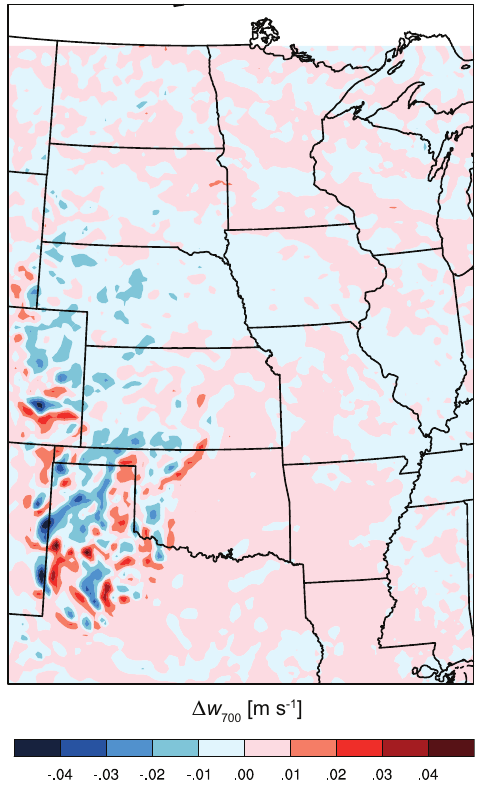
Figure 9. Difference in monthly-mean 700-mb vertical velocities between the IRR and CTL simulations for the month of July (m · s − 1